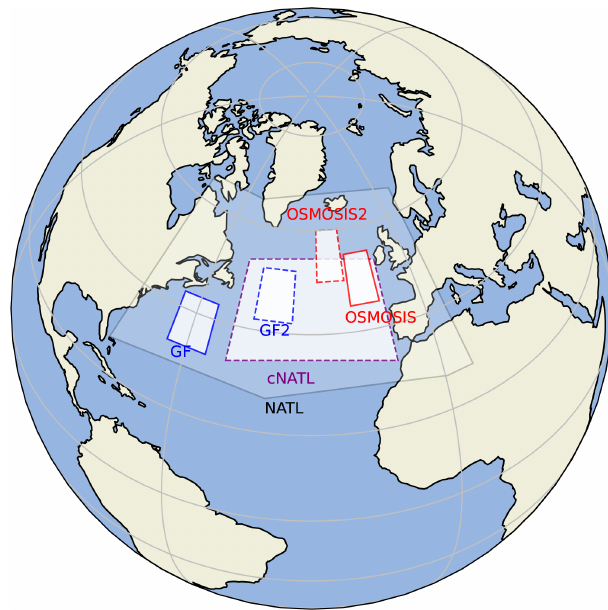
Figure 3. Extents of the GULFSTREAM, GULFSTREAM2, OS- MOSIS, OSMOSIS2, and cNATL domains used in this work, which are all part of the North Atlantic (NATL) basin used in the BOOST- SWOT data